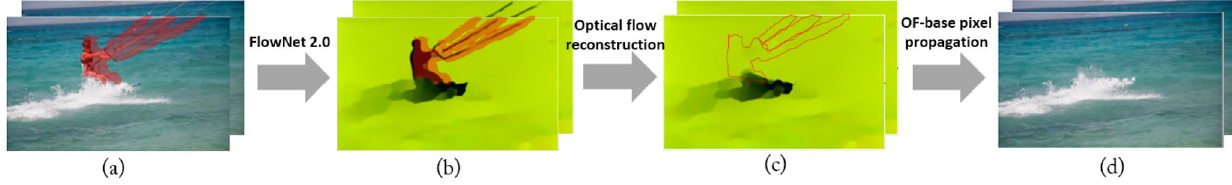
Fig. 6 Global pipeline of the optical flow-based propagation approach for reconstructing a static background. From input video (a), forward/backward optical flow fields are estimated by FlowNet 2.0 (b), and then are inpainted by an image inpainting algorithm (c). From these optical flow fields, pixels from the source region are propagated into the missing region